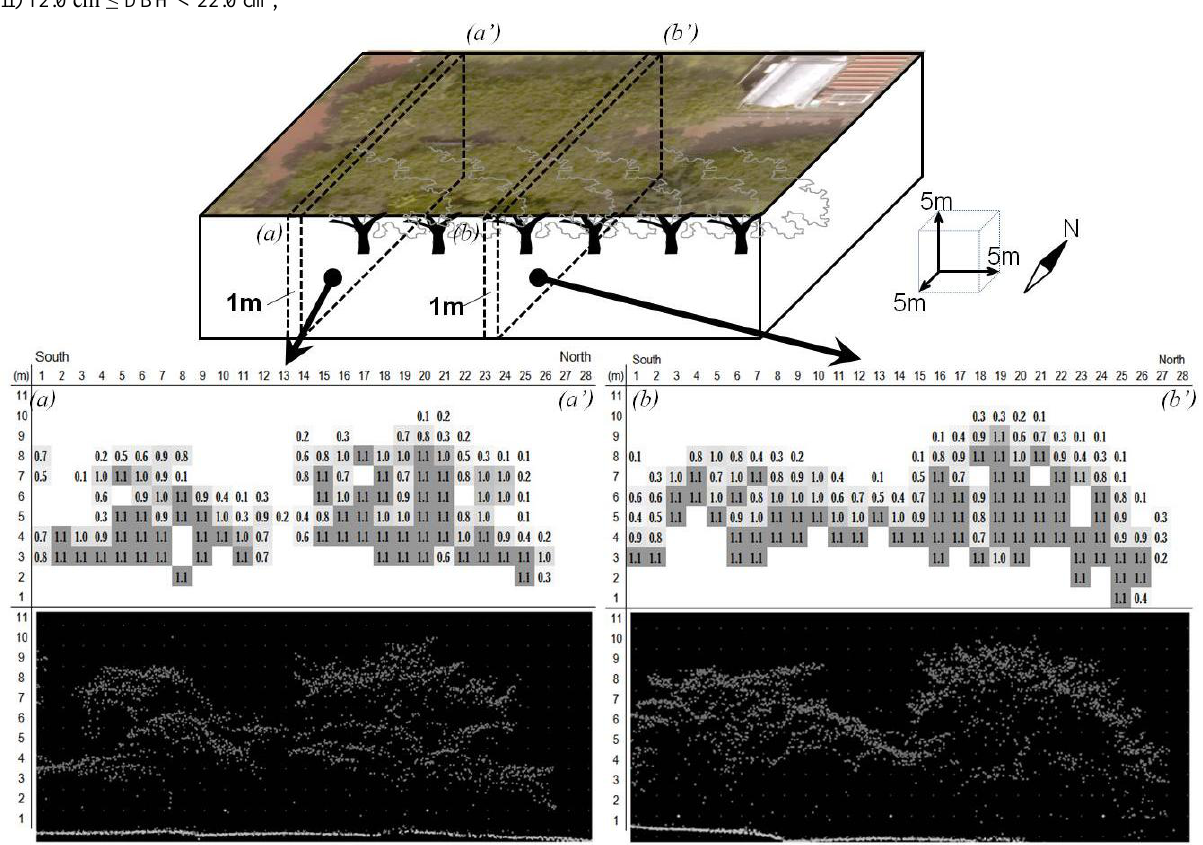
Figure 4. Example of cross section views (with 1m depth) Top plate shows the airborne digital camera image on the part of study site in the 3-dimentional view. Blocks in the middle are the distribution of PAD, which are estimated for each 1-m voxel at the cross section ( a )-( a’ ) in the left-hand side and ( b )-( b’ ) in the right-hand side, respectively. And the bottom blocks are the ALS data sources appearing as point